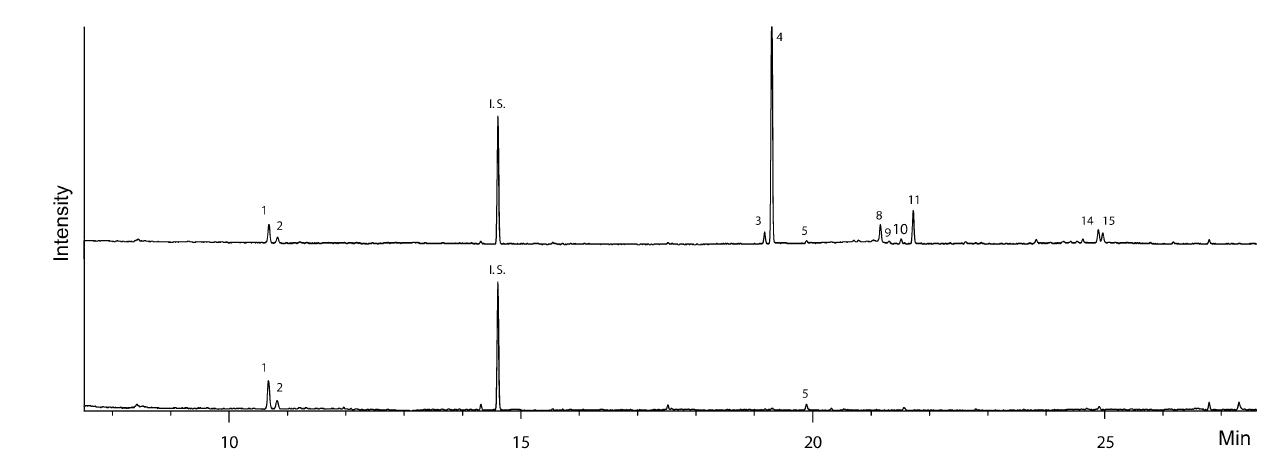
Figure 6. Comparison of the gas chromatogram of extracts of the osmeterial secretion (up) against the hemolymph of Battus polydamas archidamas (down). I.S. = internal standard (1-bromooctane). VOC identification is shown in Table